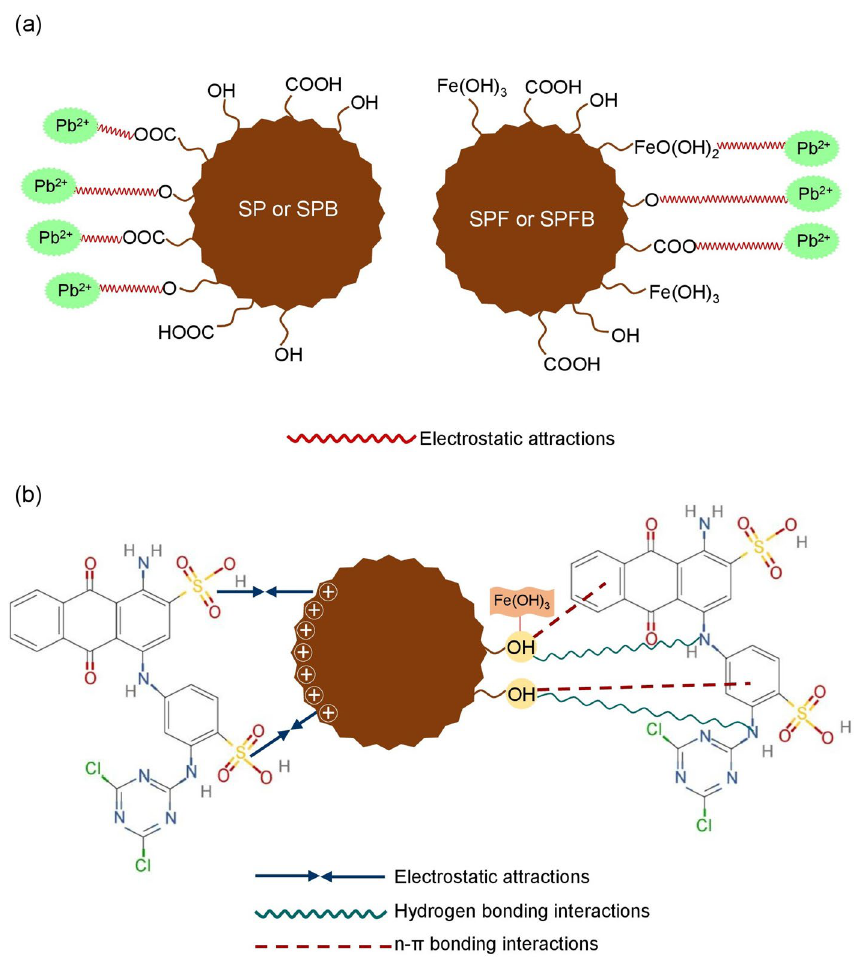
Figure 11. Possible mechanisms of ( a ) sawdust powder (SP), sawdust powder doped iron (III) oxide-hydroxide (SPF), sawdust beads (SPB), and sawdust powder doped iron (III) oxide-hydroxide beads (SPFB) for lead adsorption and ( b ) sawdust beads (SPB) and sawdust powder doped iron (III) oxide-hydroxide beads (SPFB) for RB4 dye